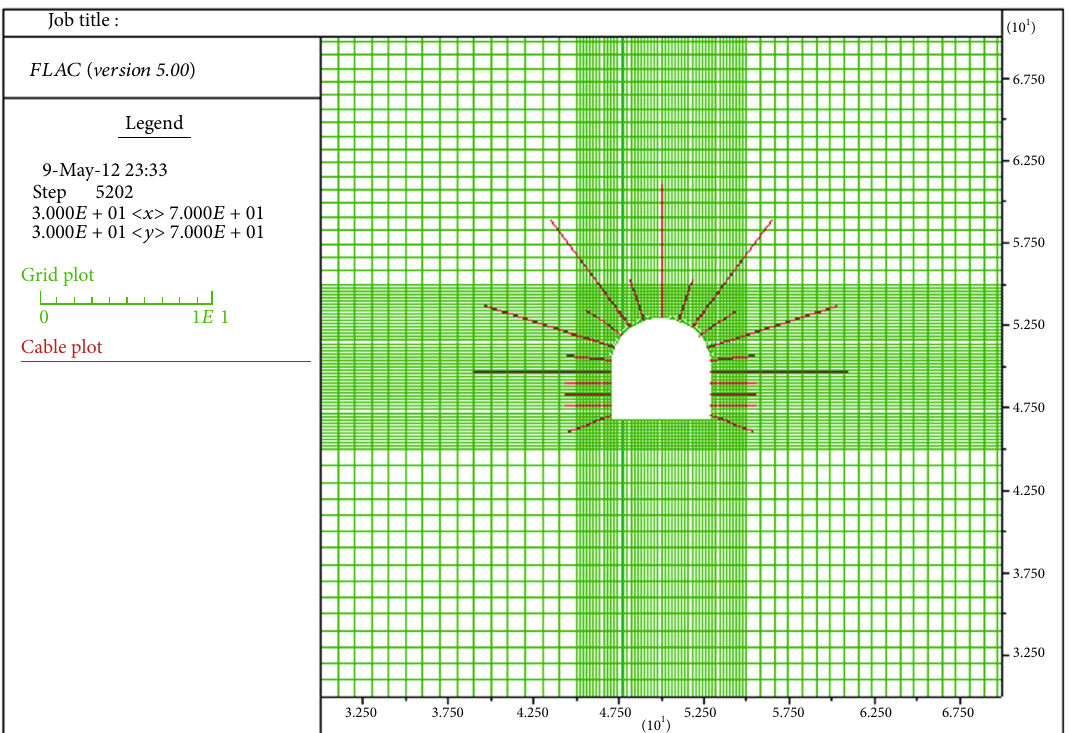
Figure 9: Numerical calculation model of the original support scheme of